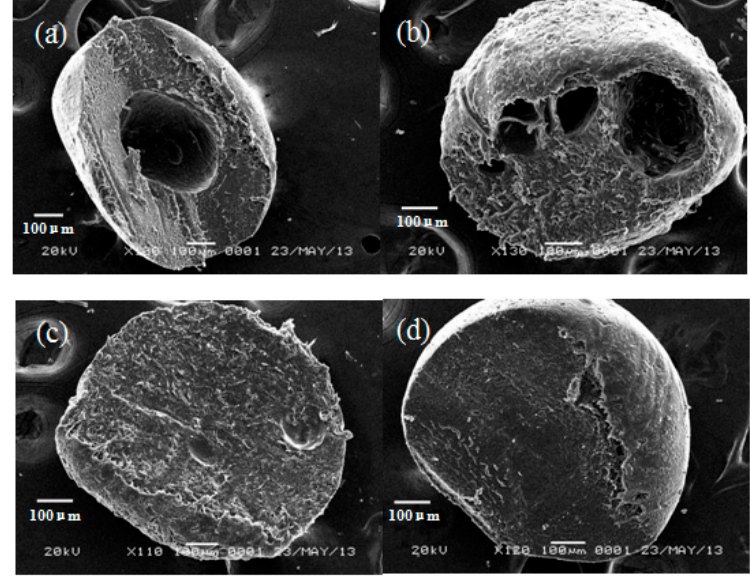
Figure 8. The cross sections of immobilized beads after the second ( a , c ) and fifth runs ( b , d ) of reactions, CB–lipase ( a , b ); CCB-3-lipase ( c , d ).